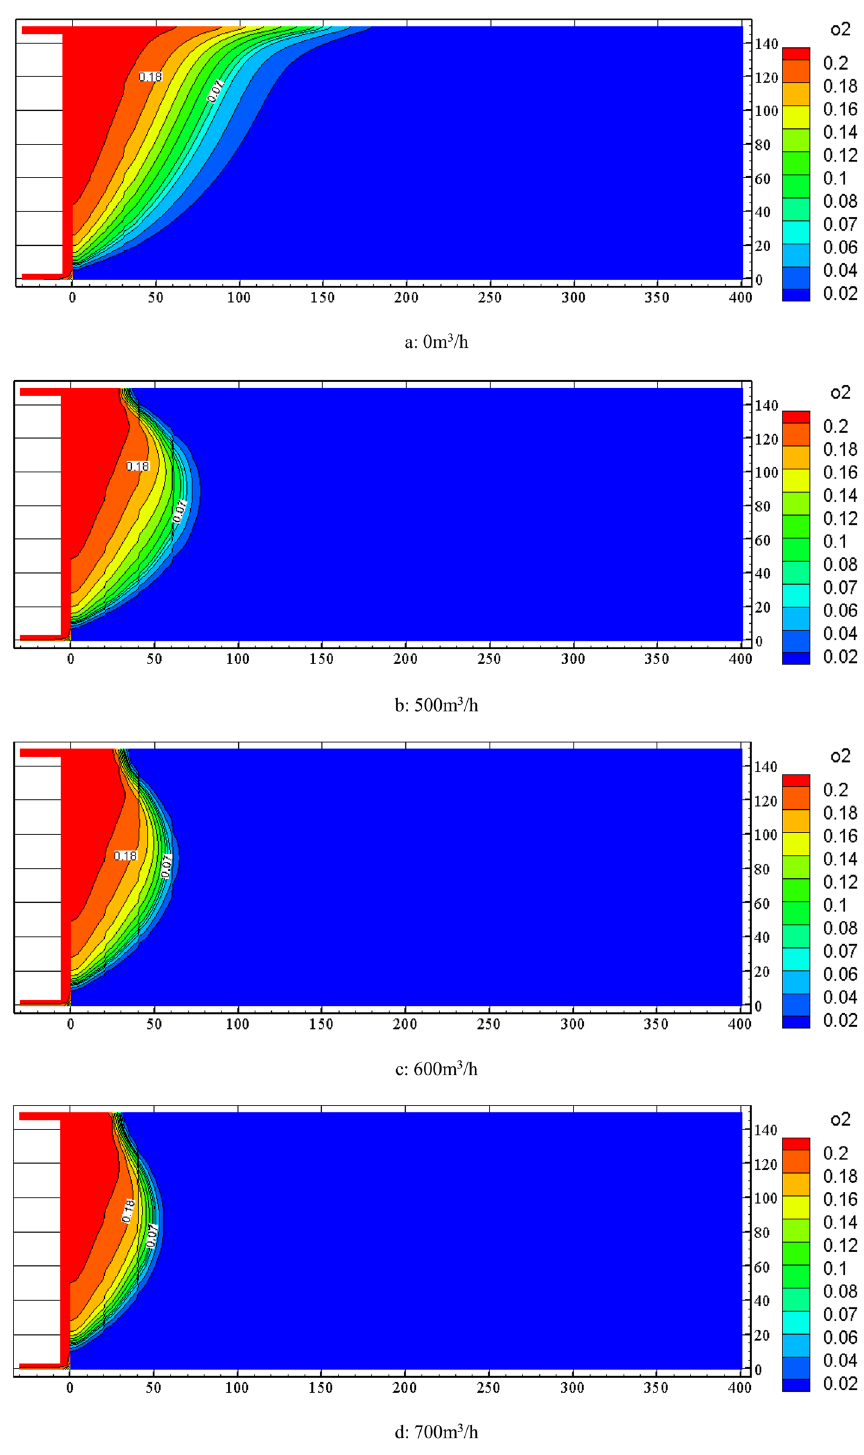
Figure 7. Distribution of oxygen concentration in goaf under different injection nitrogen